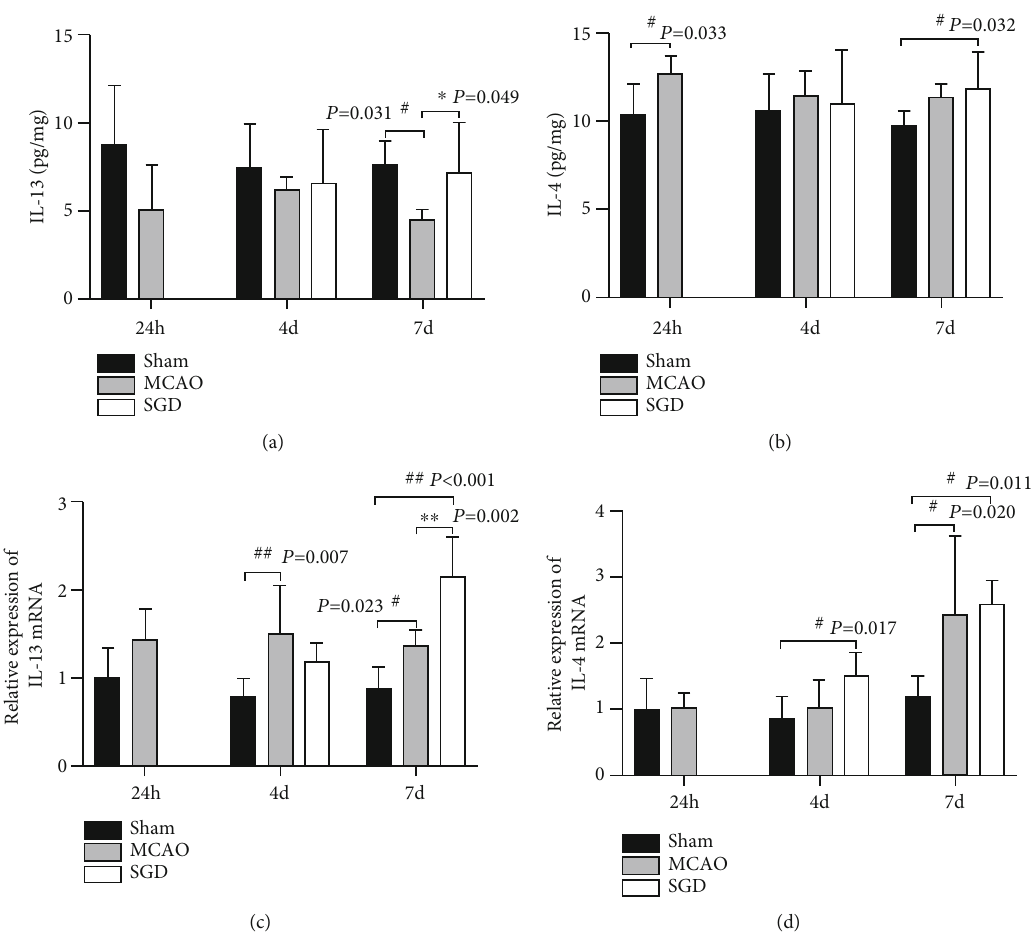
Figure 6: SGD increased the expression of IL-13 following CI/RP in rats. The levels of IL-13 and IL-4 in the penumbra were detected by Luminex and qRT-PCR on days 1, 4, and 7 post-surgery among the sham, MCAO, and SGD groups. (a, b) Comparative results of protein level of IL-13 (a) and IL-4 (b). (c, d) Statistical analysis of mRNA expression of IL-13 (c) and IL-4 (d). Results are presented as the mean ± SD , n = 4 − 5 for each group. # P < 0 : 05 , ## P < 0 : 01 vs. sham; ∗ P < 0 : 05 , ∗∗ P < 0 : 01 vs.